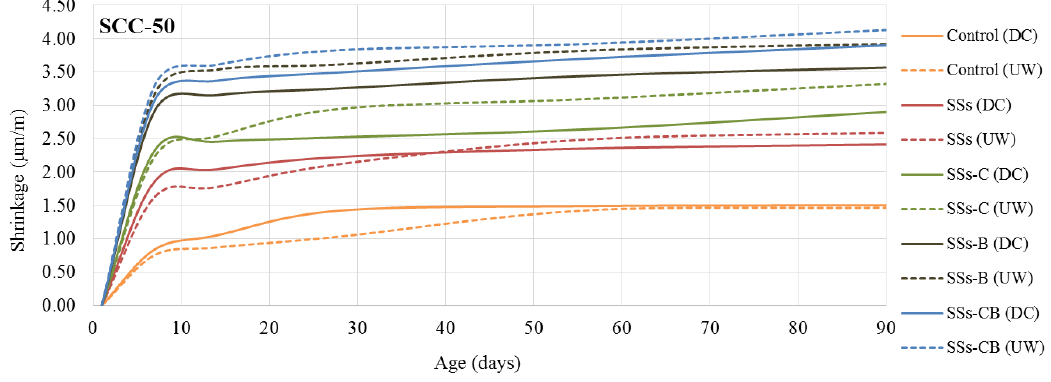
Figure 7. Shrinkage of the SCC-50 as a function of age in days. (UW) Underwater curing condition, (DC) Dry Chamber curing conditions.